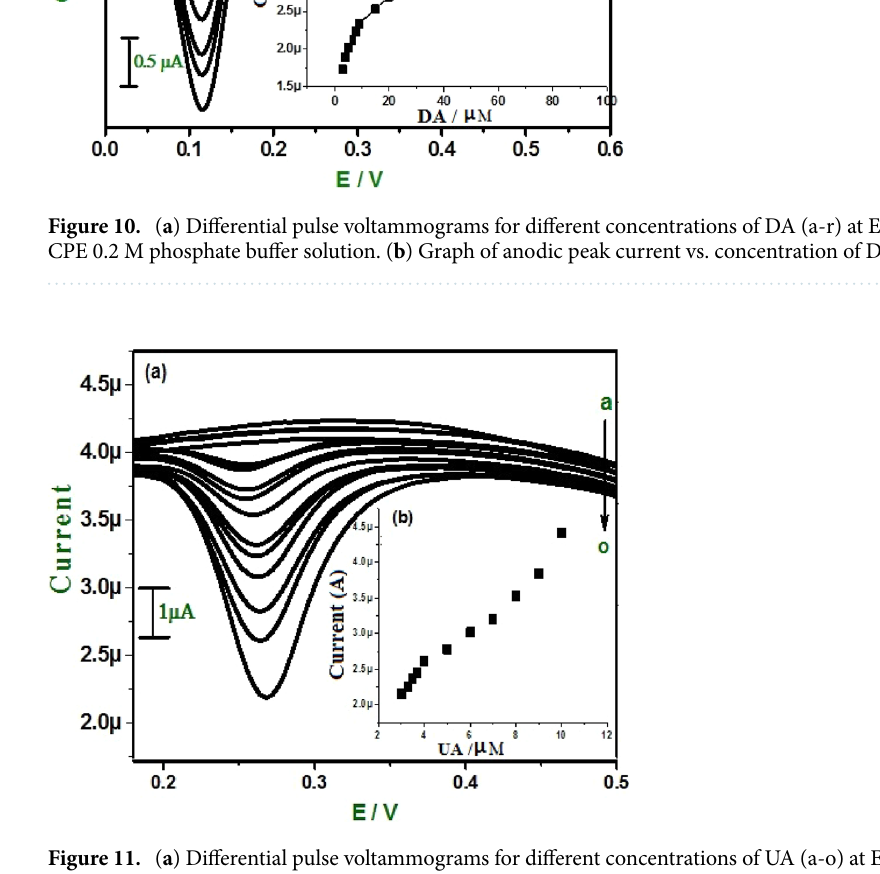
Figure 11. ( a ) Differential pulse voltammograms for different concentrations of UA (a-o) at E-GO modified CPE 0.2 M phosphate buffer solution. ( b ) Graph of anodic peak current vs. concentration of